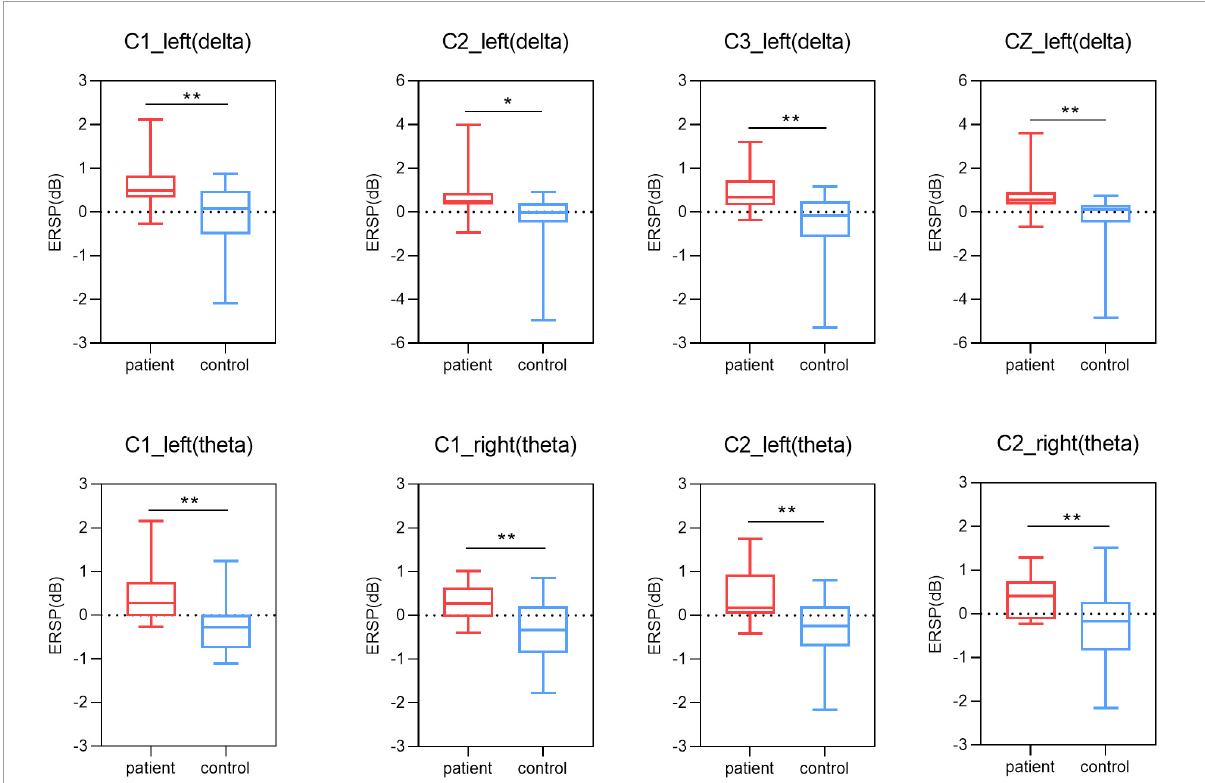
FIGURE4 Results of one-way ANOVA. Comparison of power in delta and theta band and five channels (C3, C1, Cz, C2, C4) during two motor imagery (MI) tasks (second 0–5 s of the trial) among lower limb amputees and healthy controls. Left, left-side MI task; right, right-side MI task; * p < 0.05; ** p <